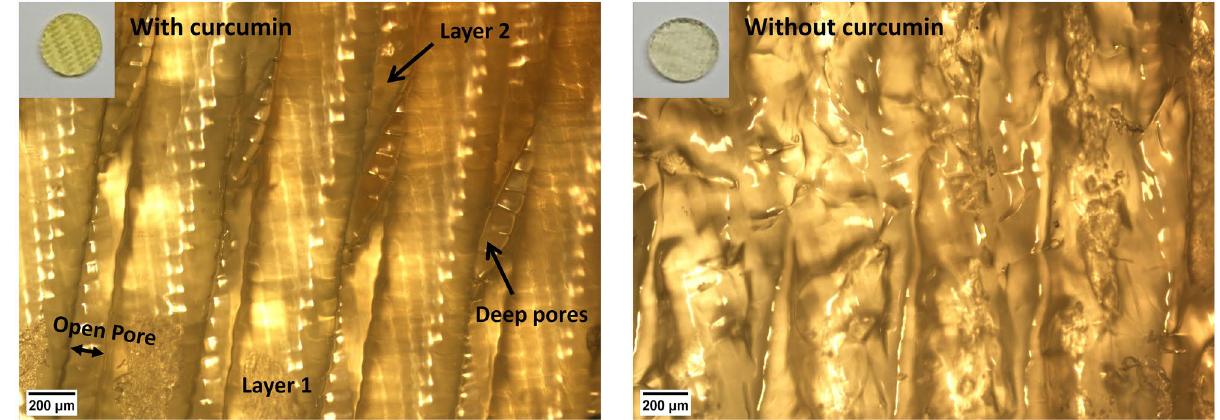
Figure 4. Role of curcumin in our custom-built 3D printing setup. Scaffold demonstrated well defined morphology and open pores with curcumin in the precursor solution (left, 5X). In the absence of curcumin, the layers diffused into each other leading to poor scaffold morphology and closed pores (right, 5X). Characteristic yellow color can be distinguished between scaffolds due to curcumin in it (top left).